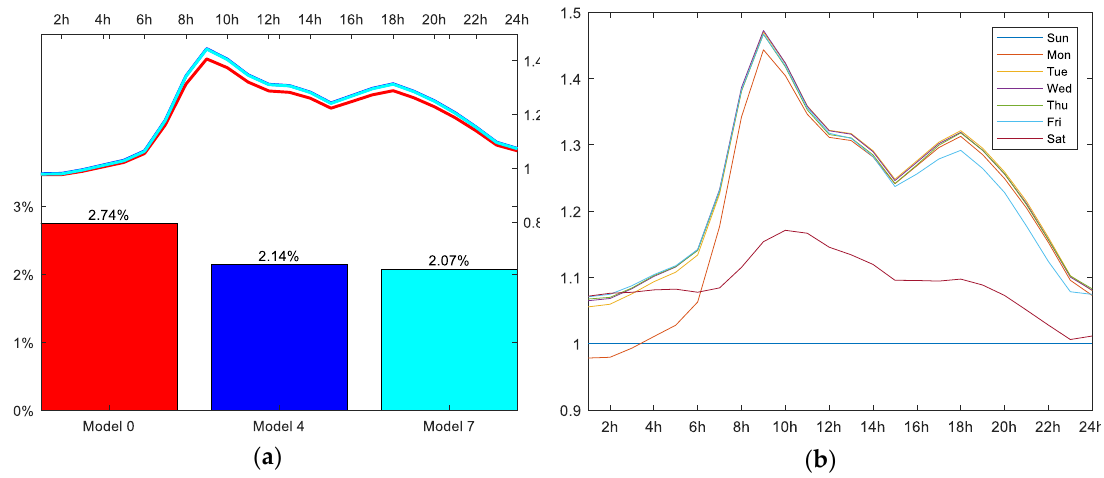
Figure 6. ( a ) Coefficient profile and error chart for regular Mondays.; ( b ) Coefficient profiles for all regular days in model 7. Sunday is a straight line because it is the reference.